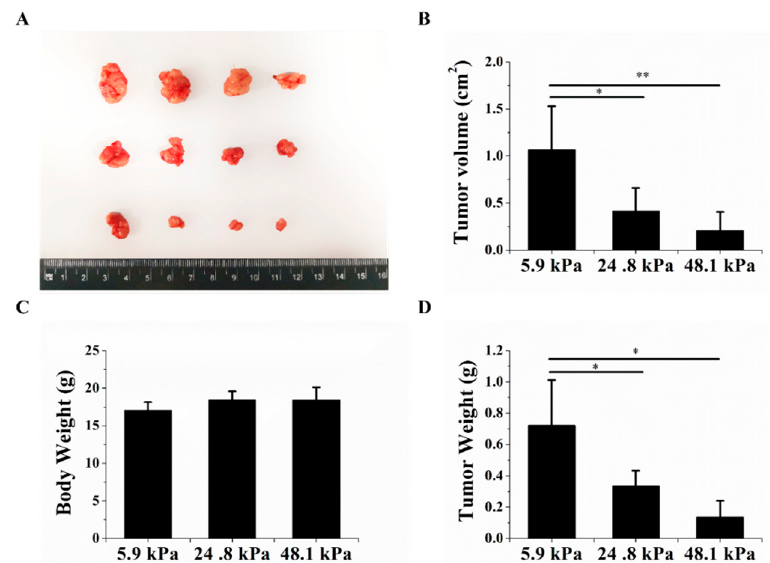
Figure 5. The matrix stiffness regulated tumorigenic potential. ( A ) The soft matrix increased tumor formation; soft matrix (top), medium matrix (middle), and stiff matrix (bottom). ( B , C ) The soft matrix increased the subcutaneous xenograft weight and volume. ( D ) Changes in the body weights of nude mice 23 days after injection. The values are presented as the mean ± SD of three independent experiments. n = 4; * p < 0.05; and ** p < 0.01.